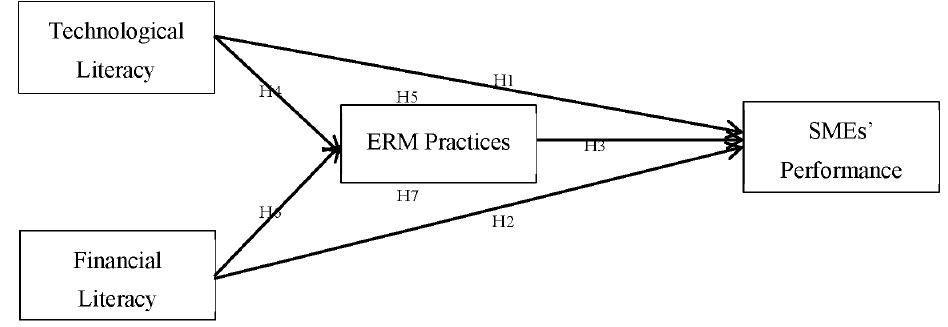
Figure 1. Conceptual framework.